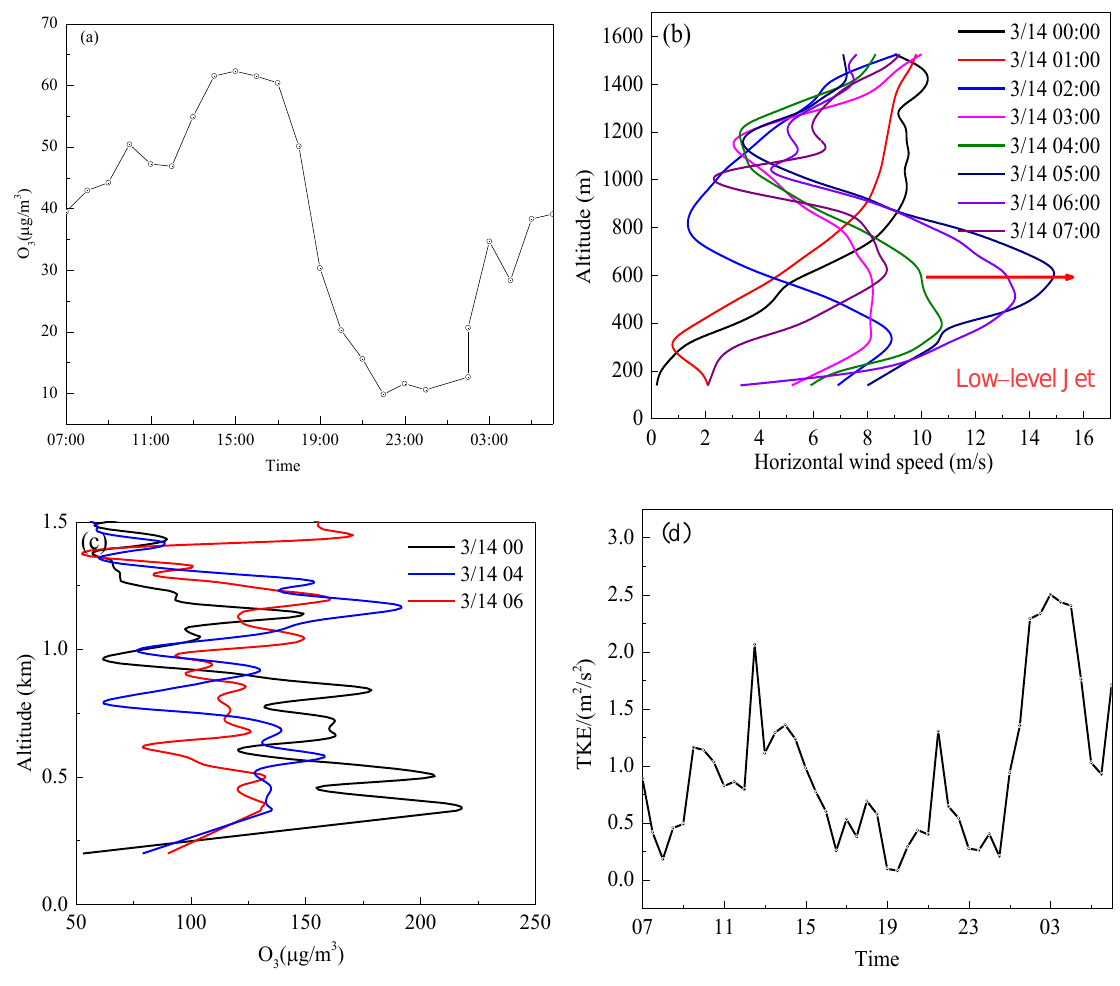
Figure 6. ( a ) Temporal change in hourly ozone concentration from 07:00 LT on 13 March to 06:00 LT on 14 March 2020; ( b ) Horizontal wind speed profiles from 00:00 to 06:00 LT on 14 March 2020, respectively; ( c ) Ozone concentration profiles at 00:00, 04:00, and 06:00 LT on 14 March 2020, respectively, which were observed by atmospheric ozone detection lidar on the Futian Archives building (indicated by black pentagram in Figure 7); ( d ) Characteristic variations in TKE at 40 m from the meteorology tower from 13 to 14 March 2020.